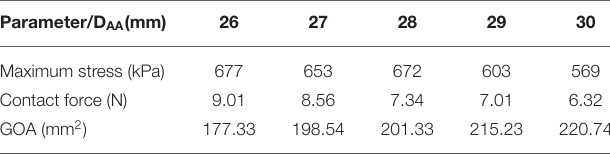
TABLE 4 | Parameter values of the model with a valve height of